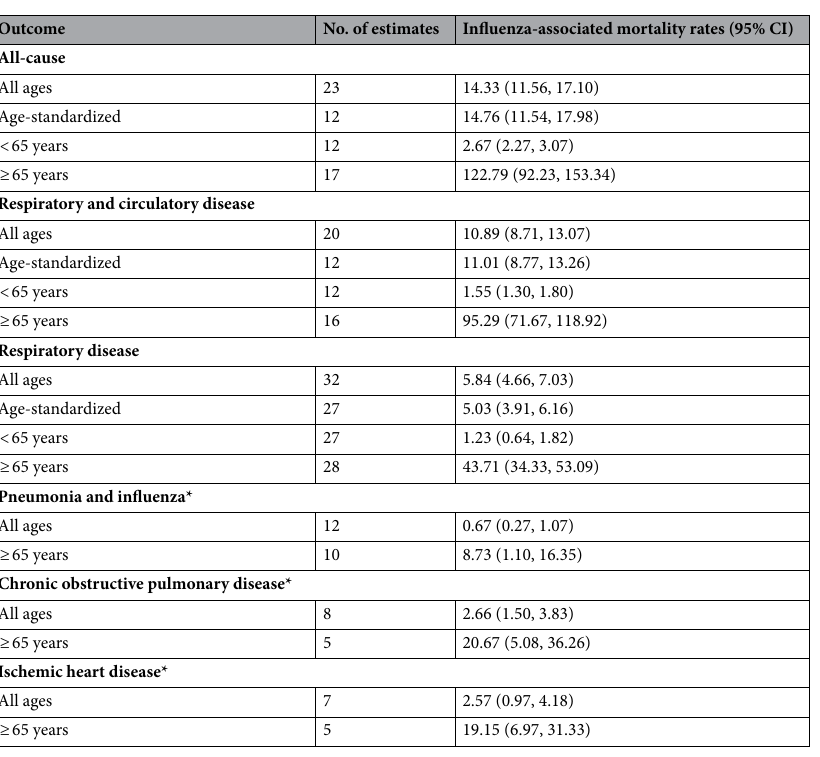
Table 1. Pooled influenza-associated mortality rates per 100,000 persons by cause of death and age group. *Due to the small numbers (< 5) of the reported estimates for age-standardized and < 65 years, the meta- analyses were not